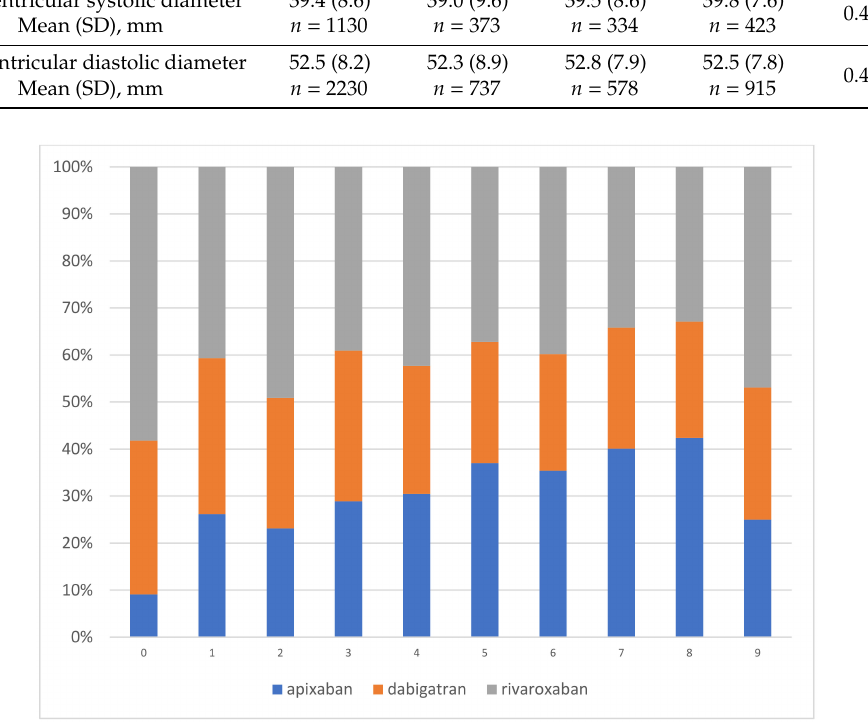
Figure 2. The prescription patterns for specific NOACs based on their CHA2DS2-VASc scores. In the study group, 36% of patients were treated with a reduced NOAC dose. Among 1071 patients who were treated with the reduced dose of NOACs, inappropriately reduced doses were observed in 242 patients (22.6%). The reduced dose of NOACs was used in 35% of apixaban patients, 39.7% of dabigatran patients, and 34.4% of rivaroxaban patients ( p = 0.037). In most patients (81.8%), the same NOAC as recommended at discharge was used before hospitalization (Table